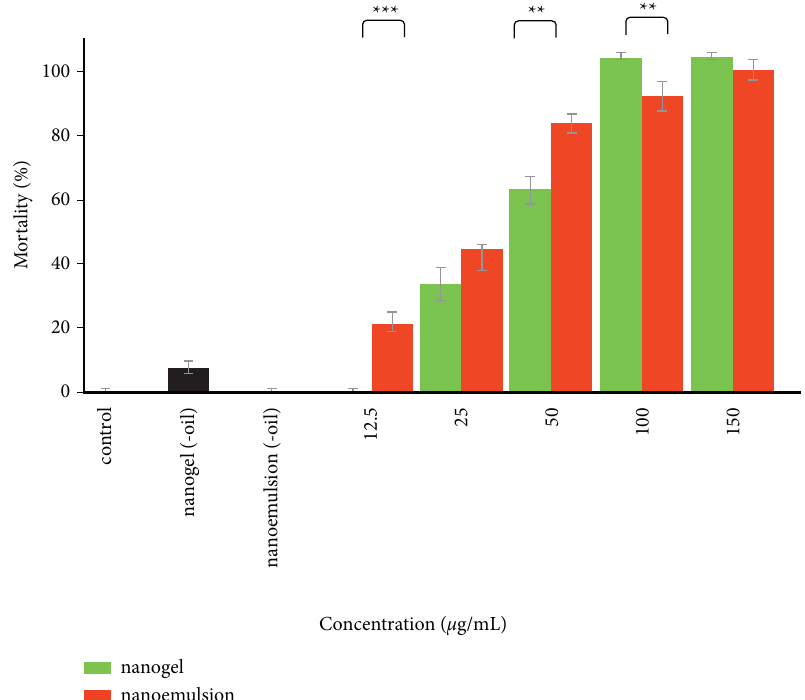
Figure 5: The larvicidal activities of EGEO-nanogel and EGEO-nanoemulsion against A. stephensi . ∗∗ : P < 0 . 01, ∗∗∗ : P < 0 .